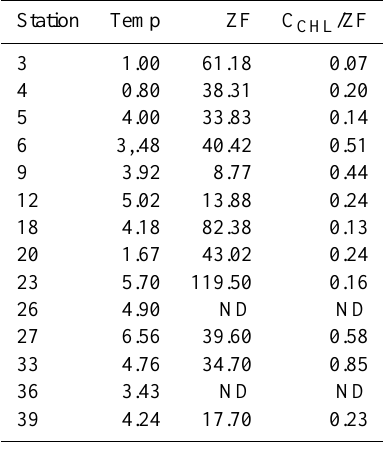
Table 1. Average temperature (Temp, average 0–100m depth, ◦ C), concentration of potential zooplankton food (total microzooplank- ton carbon, ZF, µgCL − 1 ) and proportion of > 5µm chlorophyll car- bon, C CHL , in microplankton (C CHL /ZF) at the experimental sta- tions. ND: No data. From Calbet et al. (2011).